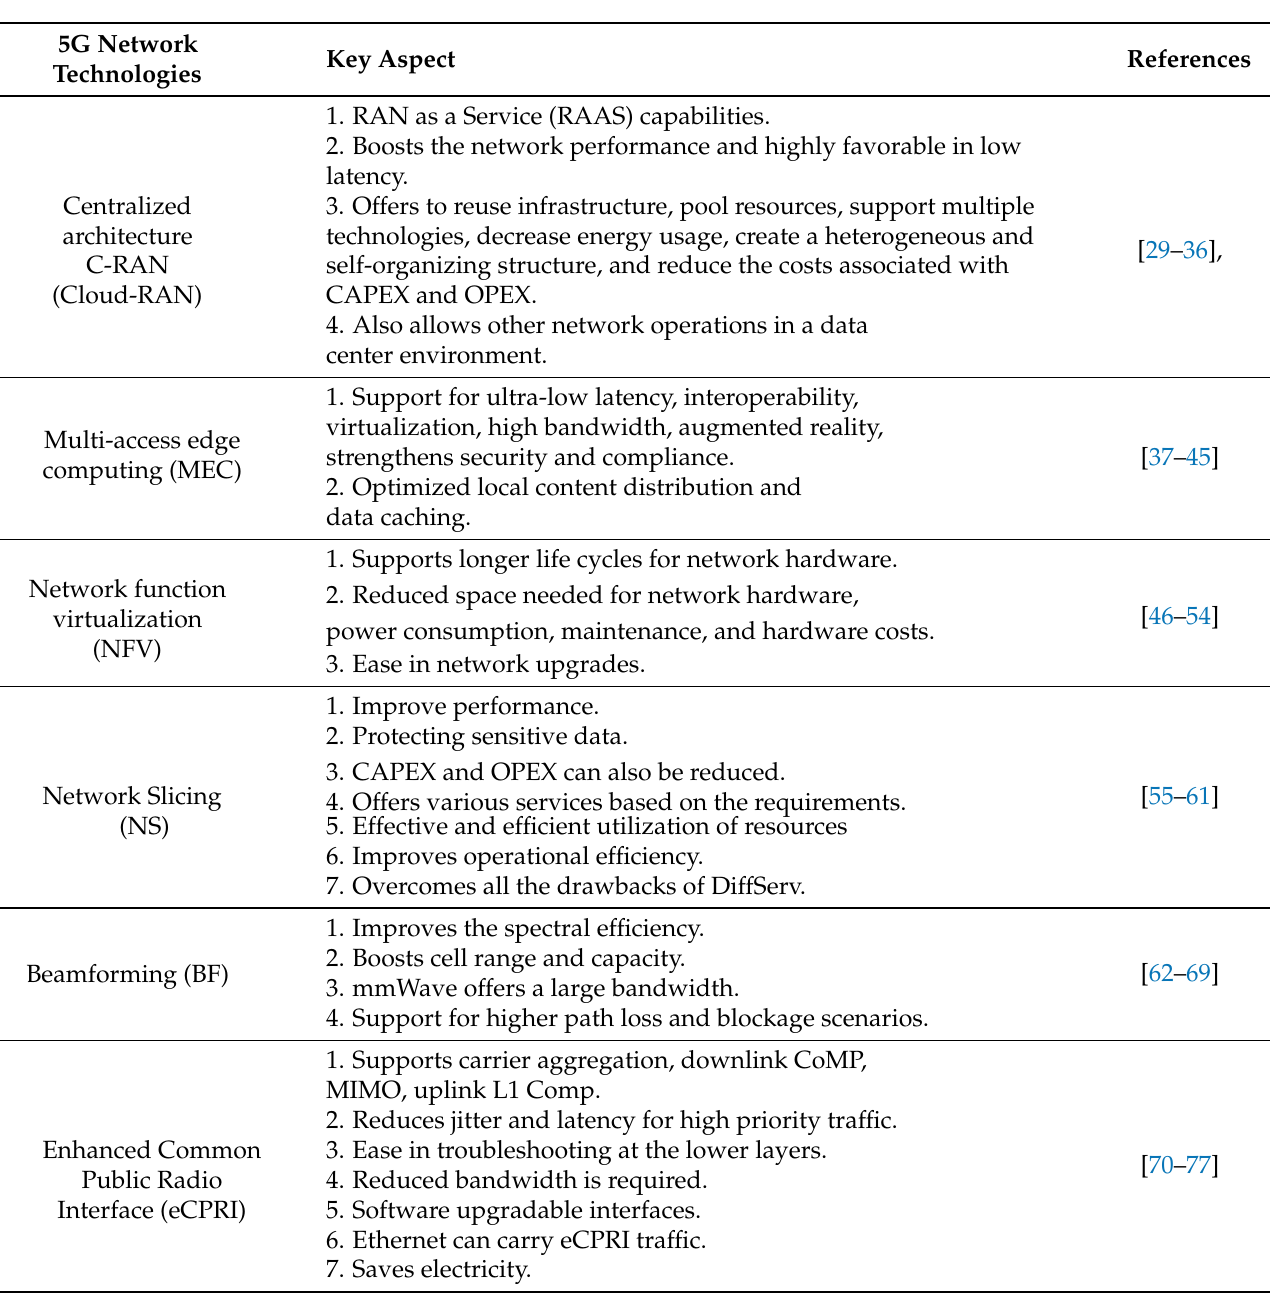
Table 2. Summary of studies on 5G network